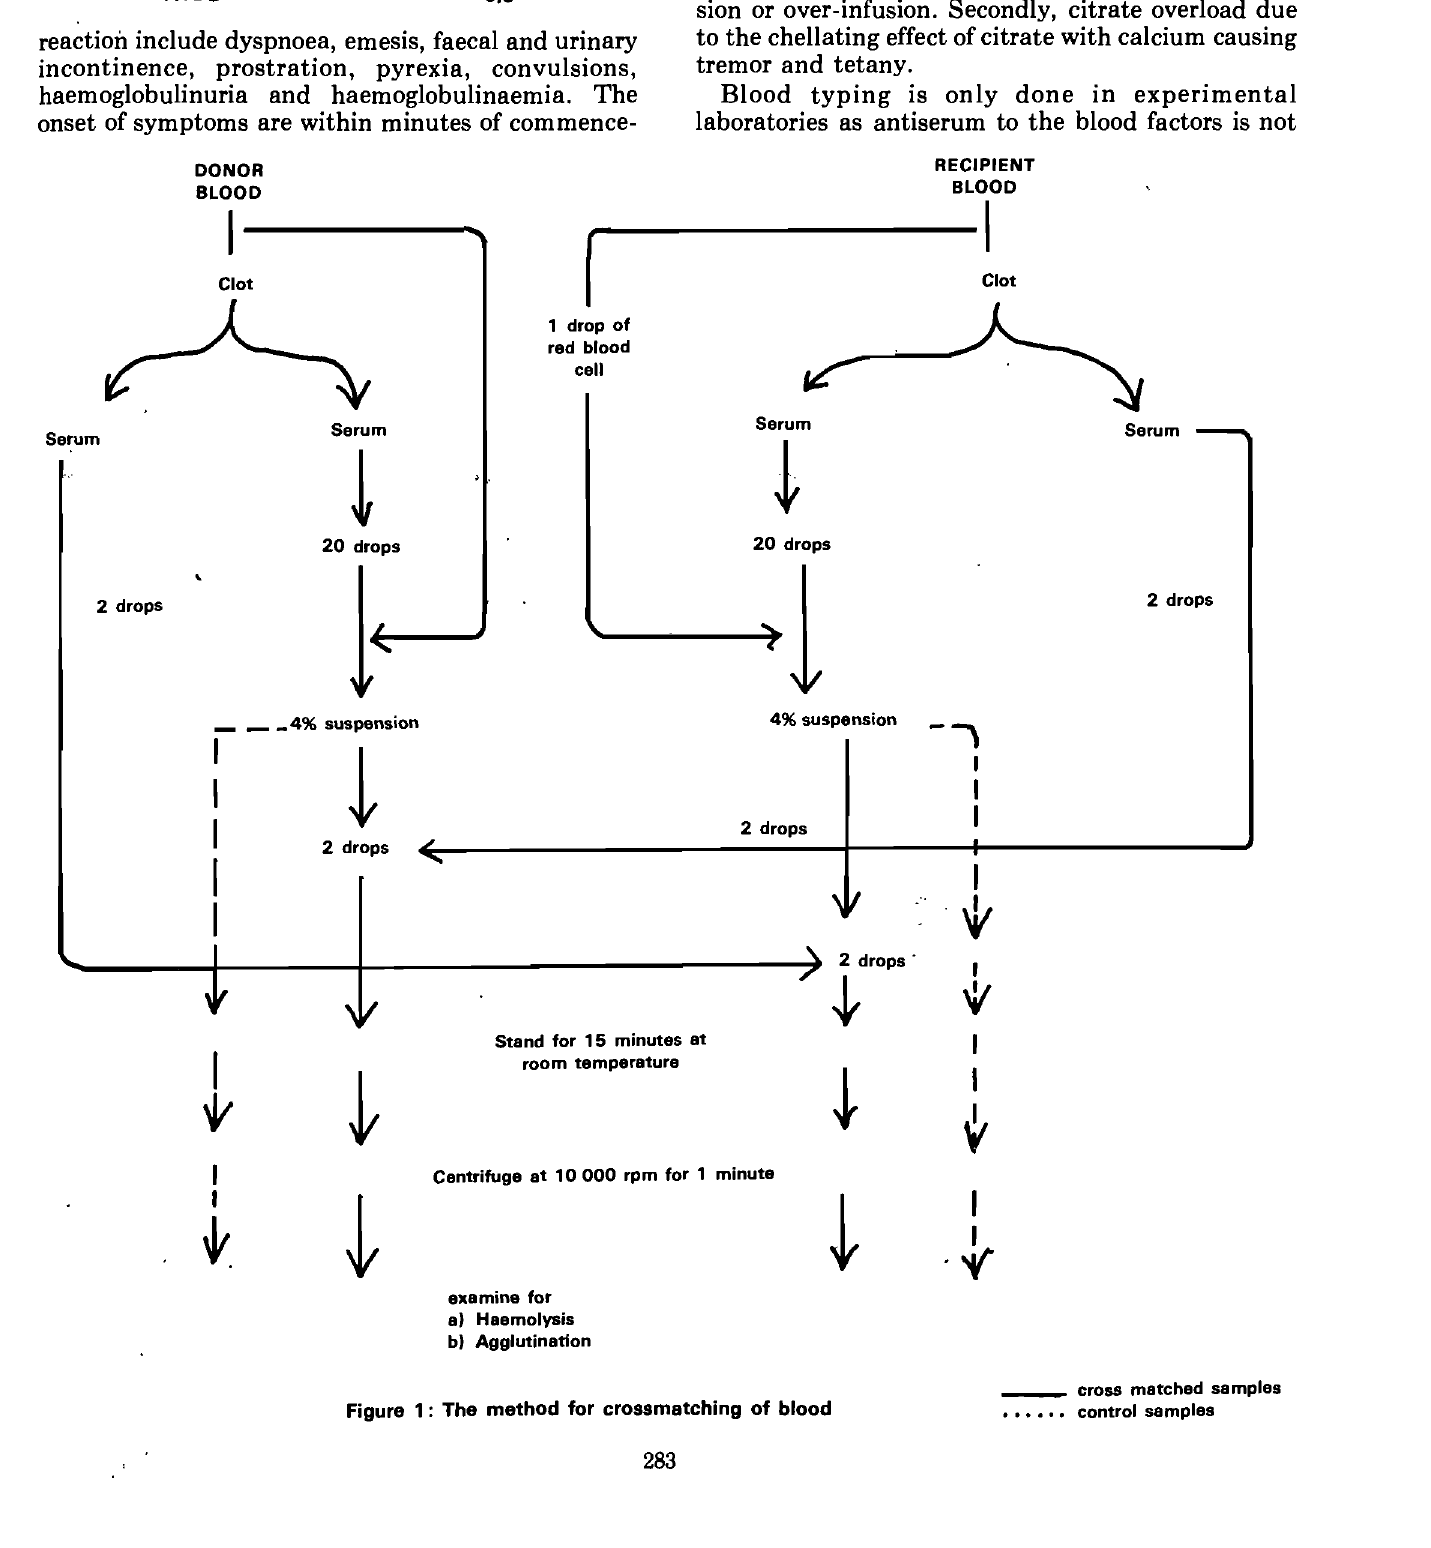
Figure 1: The method for crossmatching of blood